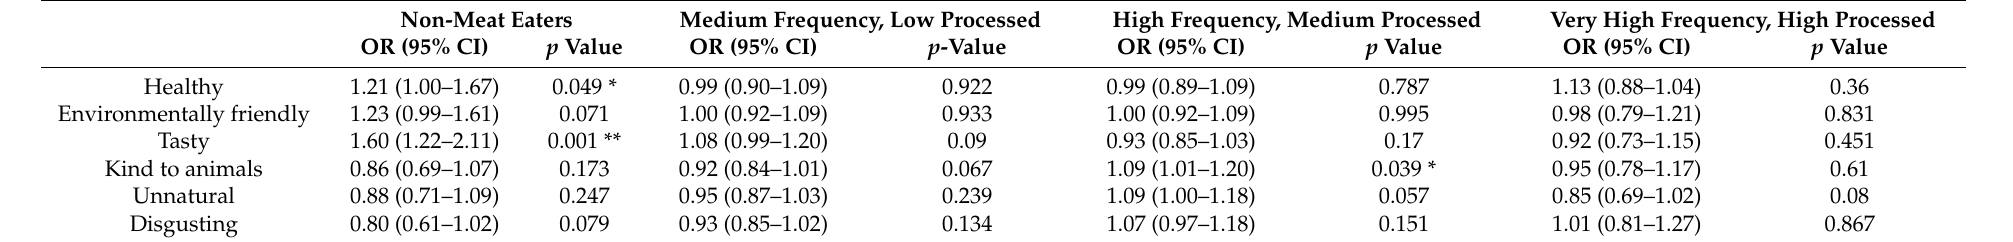
Table 5. Participants’ perceptions about cultured